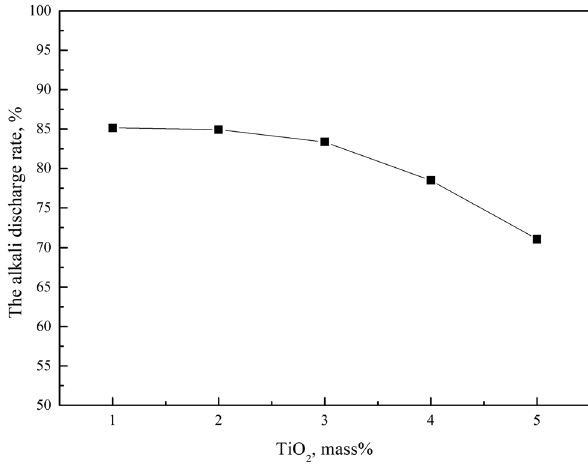
Figure 9: E ff ect of TiO 2 on slag alkali metals